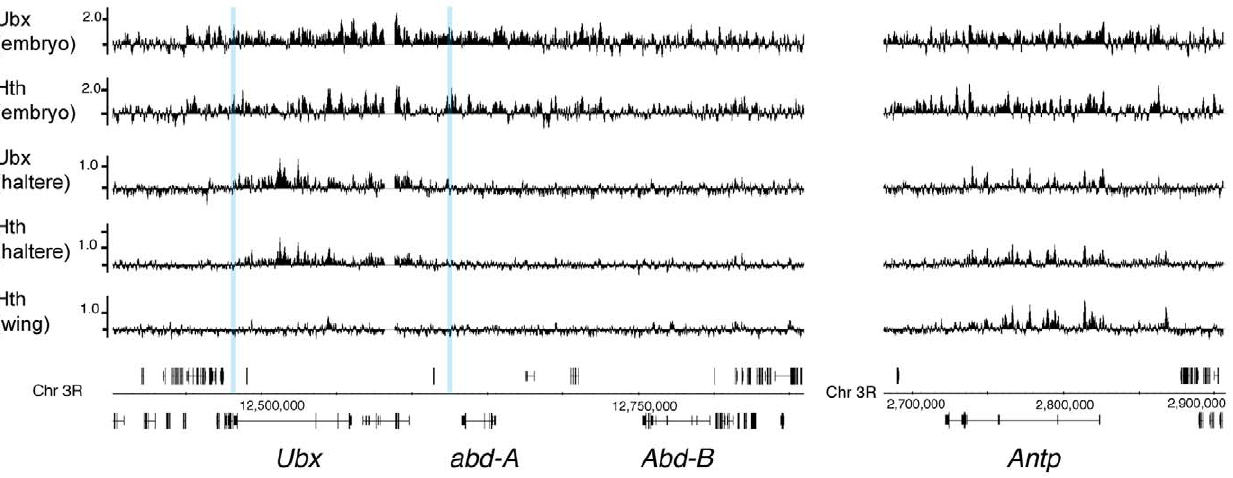
Figure 7. Ubx and Hth binding at the Bithorax complex and Antp . The embryo chromatin represents a heterogenous mixture of epigenetic ON and OFF states at the Bithorax genes and at Antp imparted by the Pc/Trx machinery. In the haltere disc chromatin Ubx and Antp are epigenetically ON, abd-A and Abd-B are OFF. In the wing disc Ubx , abd-A and Abd-B are OFF, whereas Antp is ON. The Bithorax Complex is on the left. The blue verticals represent the position of insulator component binding sites (CP190 and CTCF; [63]). The Antp locus is on the